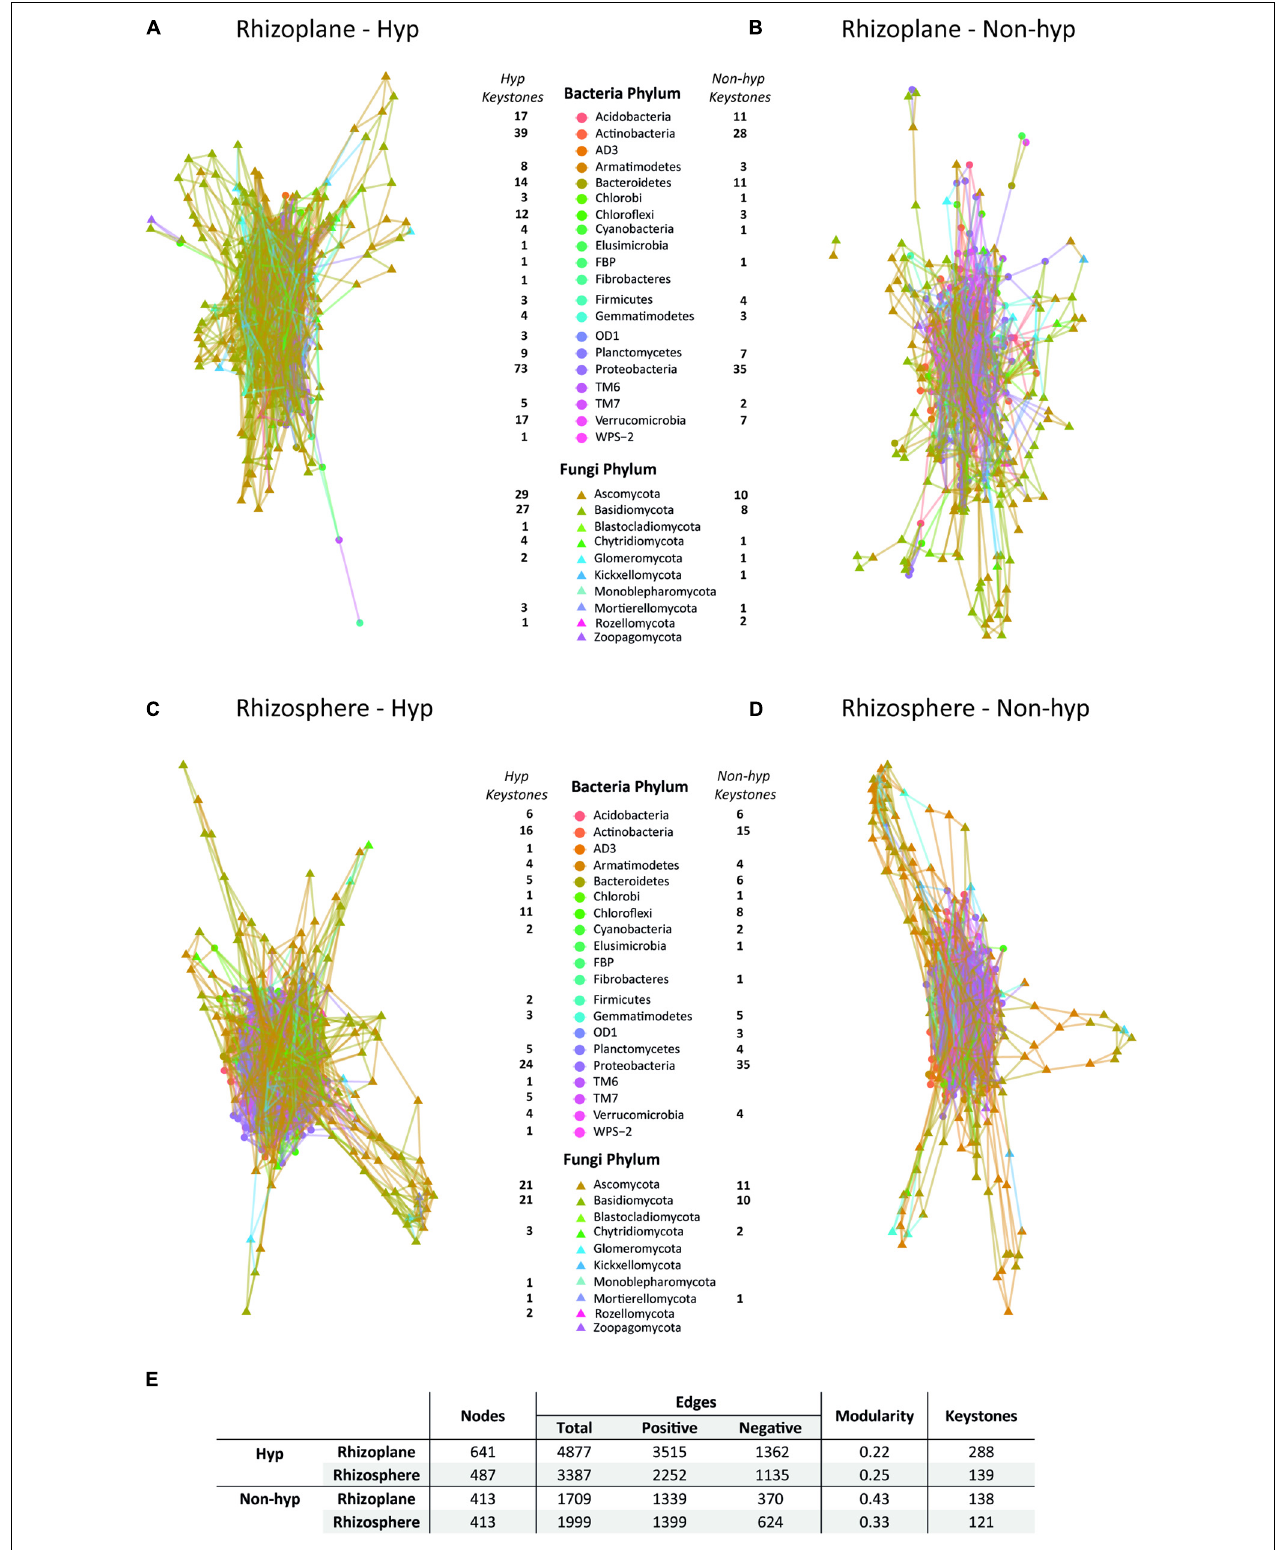
FIGURE 4 | Co-occurrence network. Potential relationship among the bacterial and fungal OTUs in the rhizoplane (A,B) and the rhizosphere (C,D) of N. brachypetala (Hyp) (A,C) , and the non-hyperaccumulator species (Non-hyp) (B,D) . (E) Table with the main parameters of the co-occurrence networks.